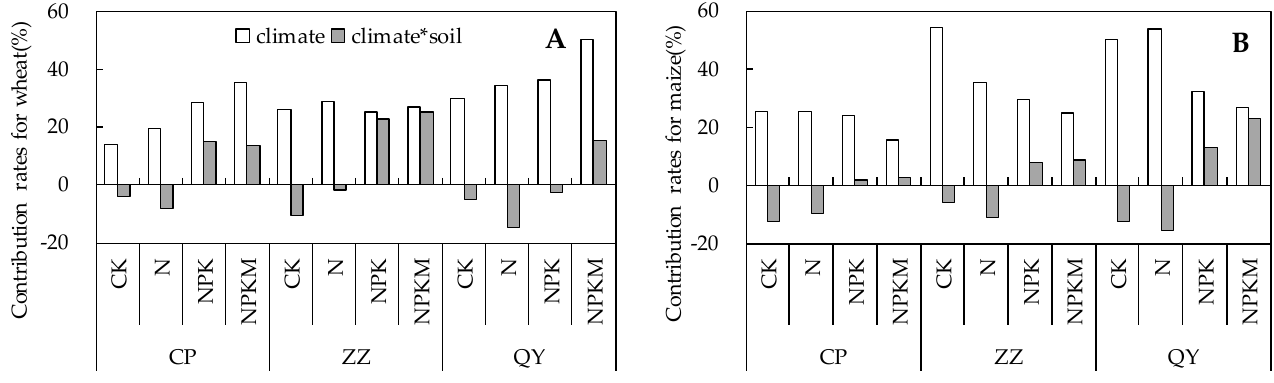
Figure 3. The contribution rates of climate, climate and soil interaction to the wheat ( A ) and maize ( B ) yields.